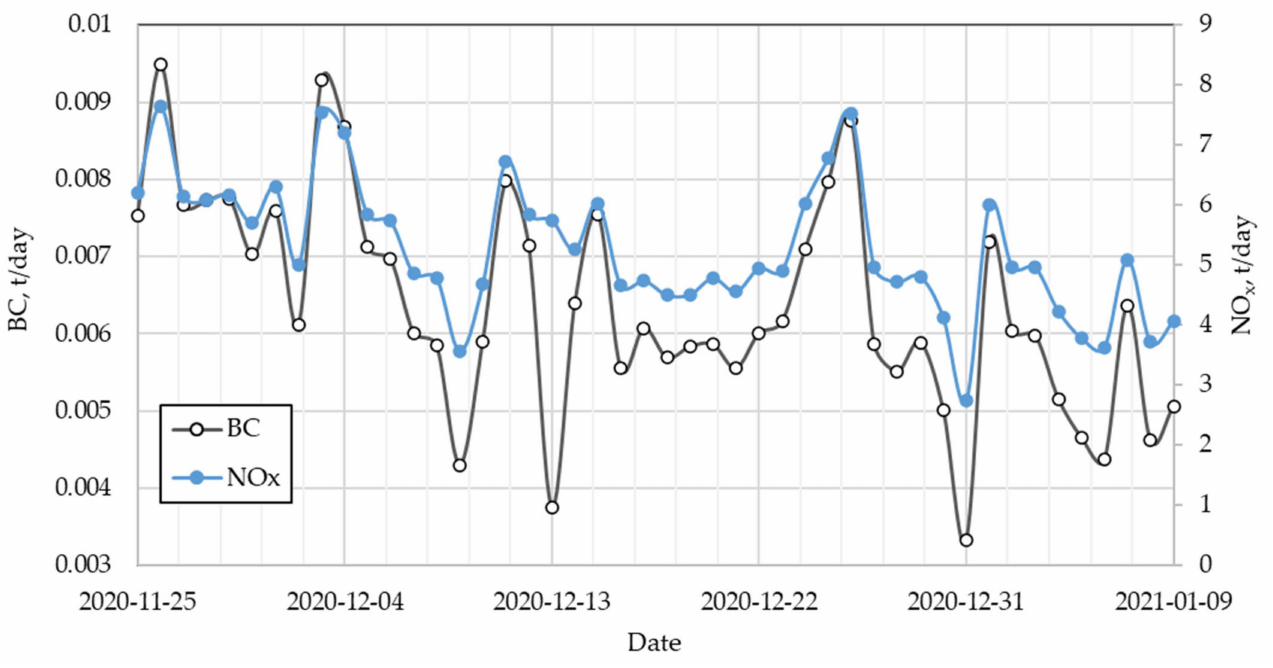
Figure 6. Summed black carbon (BC) and NO x emissions for each individual day. The dispersion of emissions also depends on the distribution intensity of emissions in the port terminals. By distributing emissions along the Klaipeda port quays, it was determined that on the quays 1; 54–57; 127 and 128 terminals where tankers (quay 1) were loaded/unloaded, in the quays 127–128 general cargo and Ro-Ro ships were loaded/unloaded, emissions were higher. The emission distribution in time by the quays, which tend to have the largest emissions, was up to 1.24 and 1.07 tons per day, respectively. Comparing these numbers with average NO x emissions in port (5.28 t NO x /day), we can see that 20% of the pollutant emission on separate days can be emitted in one place (Figures 7 and